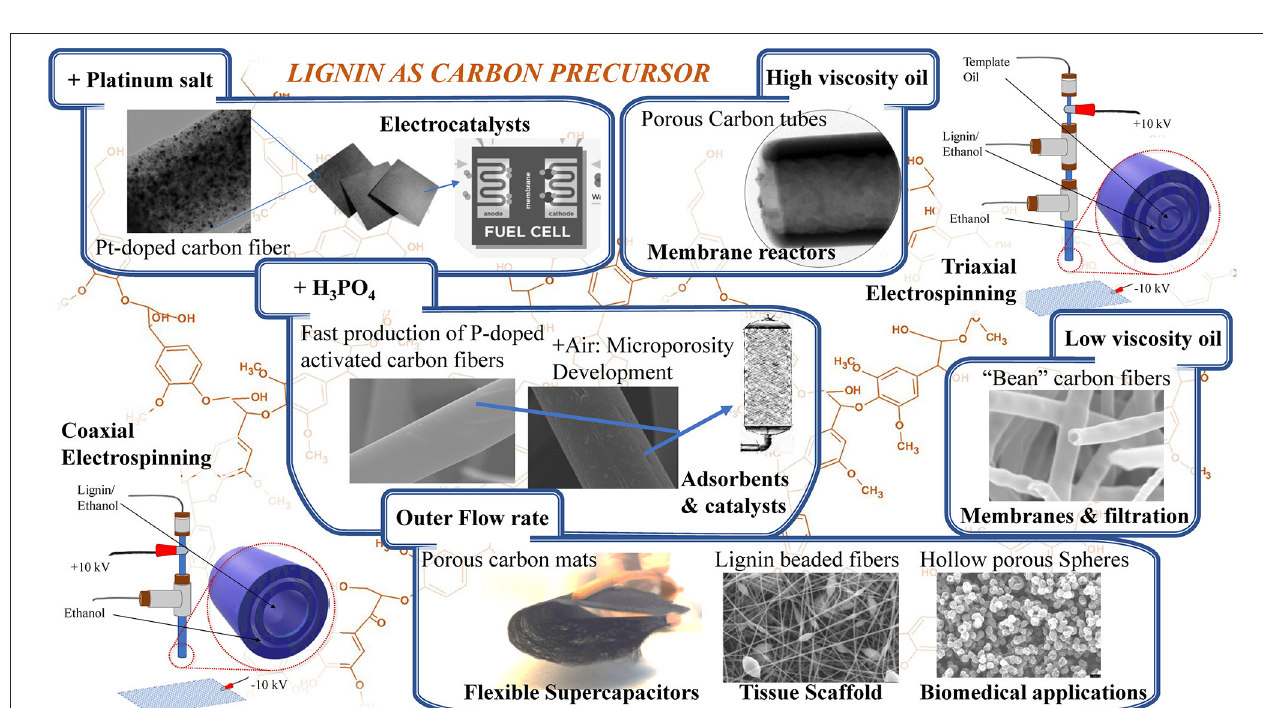
FIGURE 12 | Preparation and potential applications of the electrospun lignin-based carbon forms.